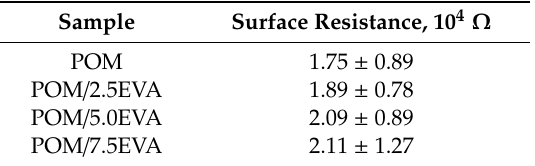
Table 7. Values of surface resistance for POM and POM / EVA blends.